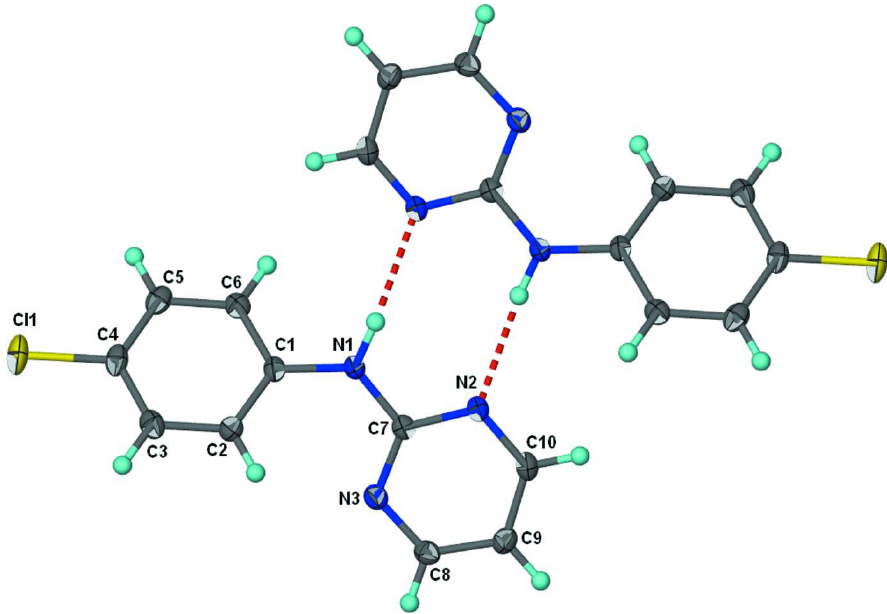
Figure 1 Thermal ellipsoid plot (Barbour, 2001) of hydrogen-bonded dimeric structure of C Hydrogen atoms are drawn as spheres of arbitrary radius. Hydrogen bonds are shown as red dashed